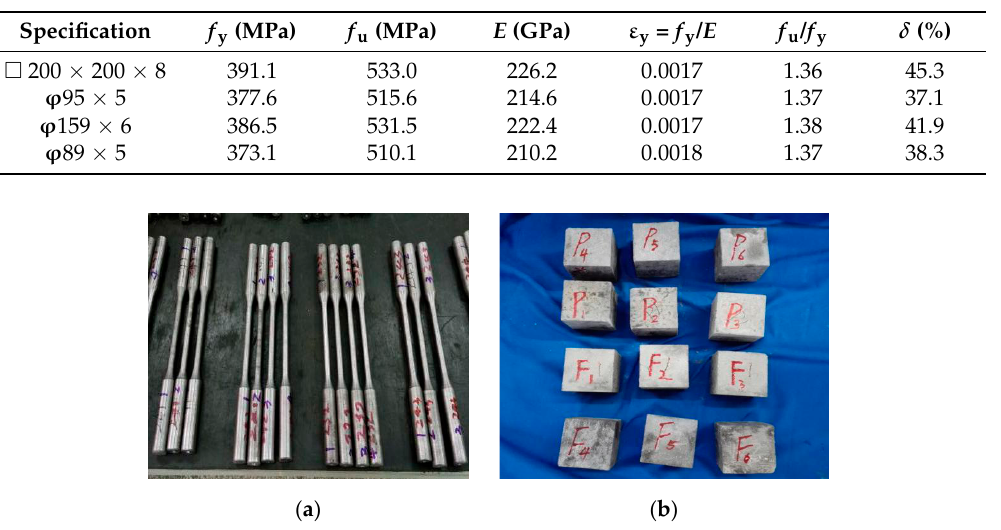
45° fly ash concrete